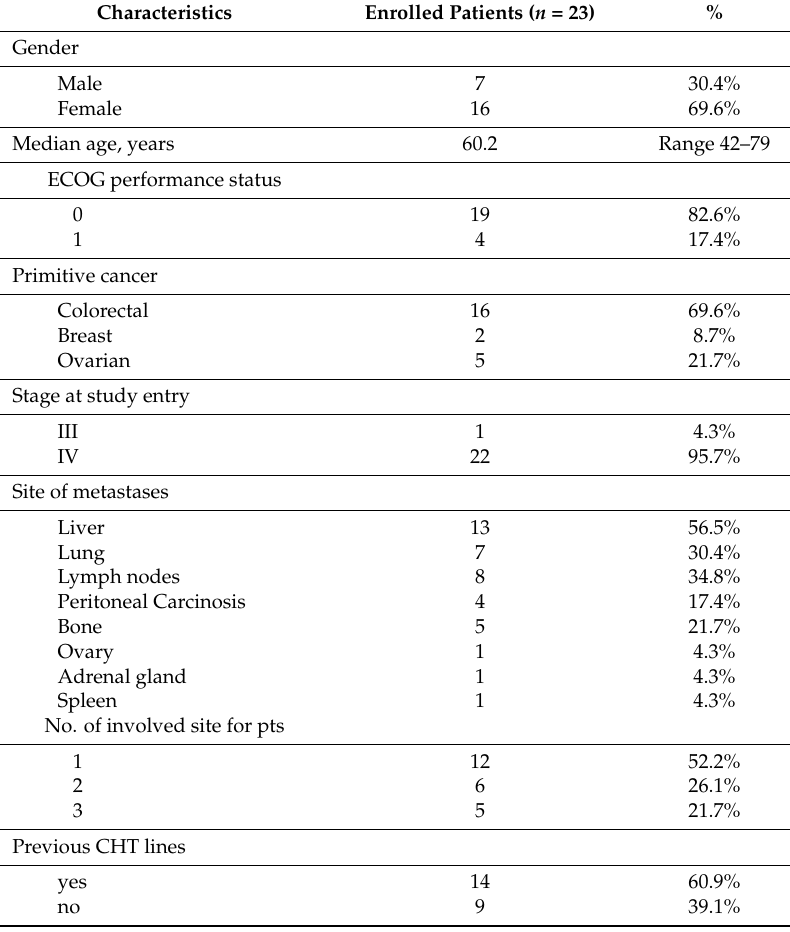
Table 1. Patients’ clinical and pathological characteristics. ECOG, Eastern Cooperative Oncology Group; CHT,